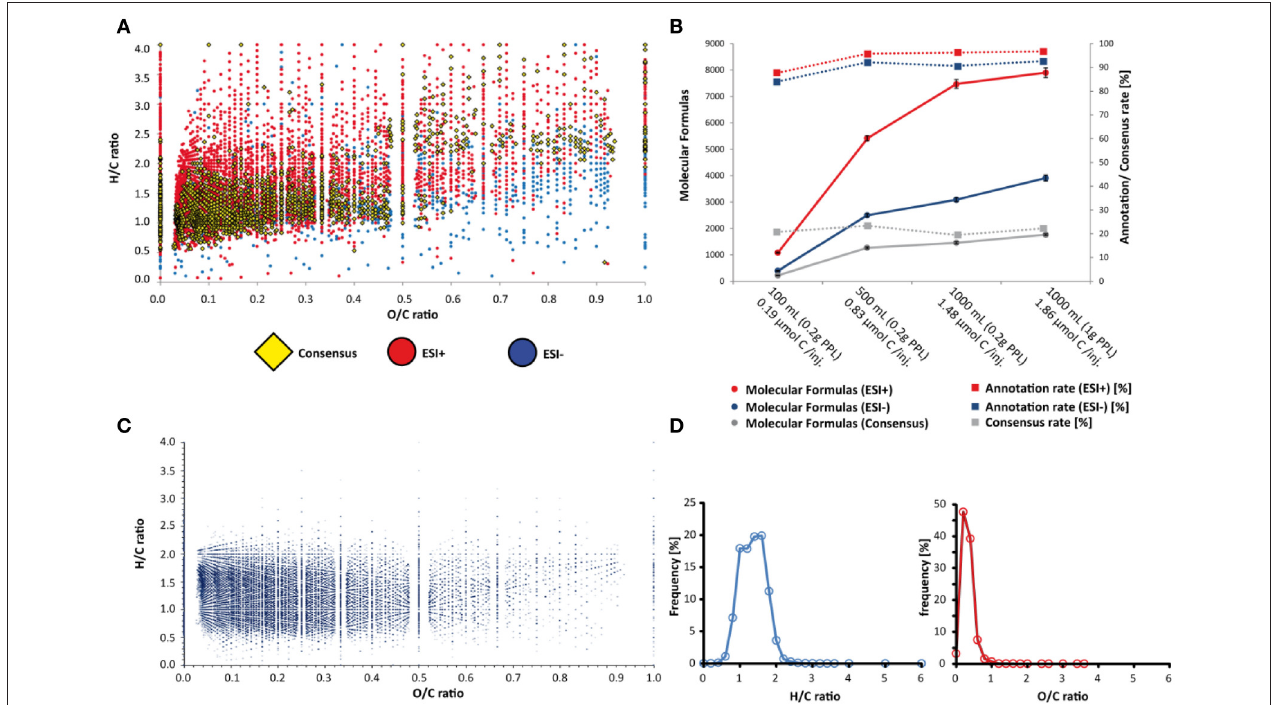
FIGURE 3 | Visualization of molecular diversity by Van Krevelen diagram and feature distribution over sample and chemical space. In (A) the H/C vs. O/C ratios of computed molecular formulas from ESI + and ESI– mode as well as from consensus features (matched XIC of at least two ion species/ adducts from both ESI + and ESI– scans) are shown. In (B) total feature numbers and formula annotation rates are shown for different ionization modes and plotted against the different extraction volumes. In B, features are labeled based on extraction volumes and total injected carbon. (C,D) displays the Van Krevelen plot and frequency distributions of